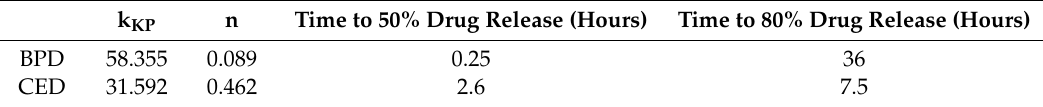
Figure 4. Release study results for CED NPs ( left ) over a 12-h period and BPD NPs ( right ) over a 4-day period in reverse dialysis 1 × phosphate buffer solution at 37 ◦ C, pH 7.4. Samples were tested in triplicate for reproducibility. Table 2. Constants for drug release kinetics using Korsmeyer–Peppas model ( n = 3).